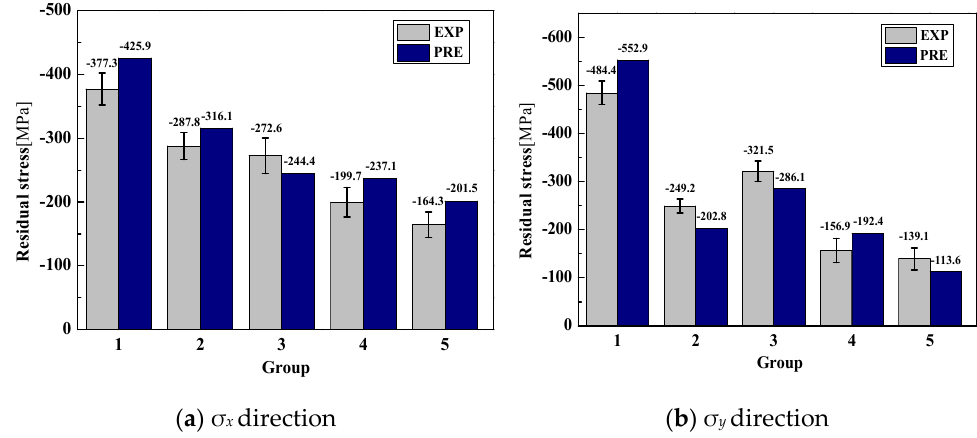
Figure 11. Experimental and predicted surface residual stress.